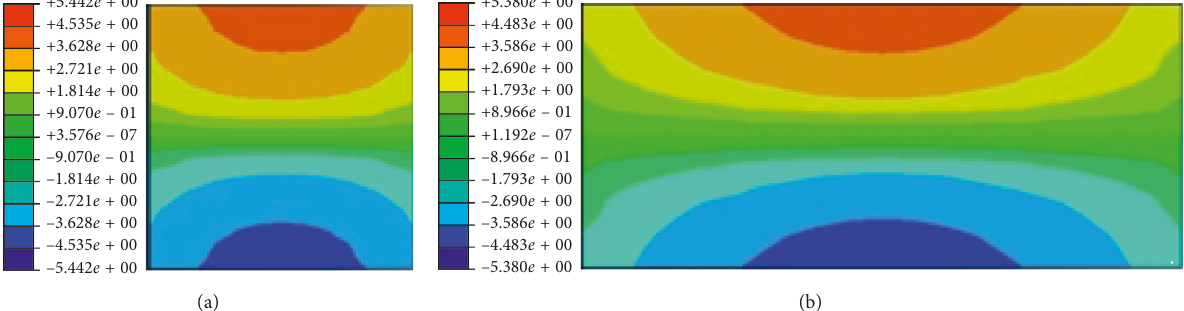
Figure 9: Cyclic stress invariant at the base of the concrete footing. (a) Configuration-1. (b) Configuration-2.